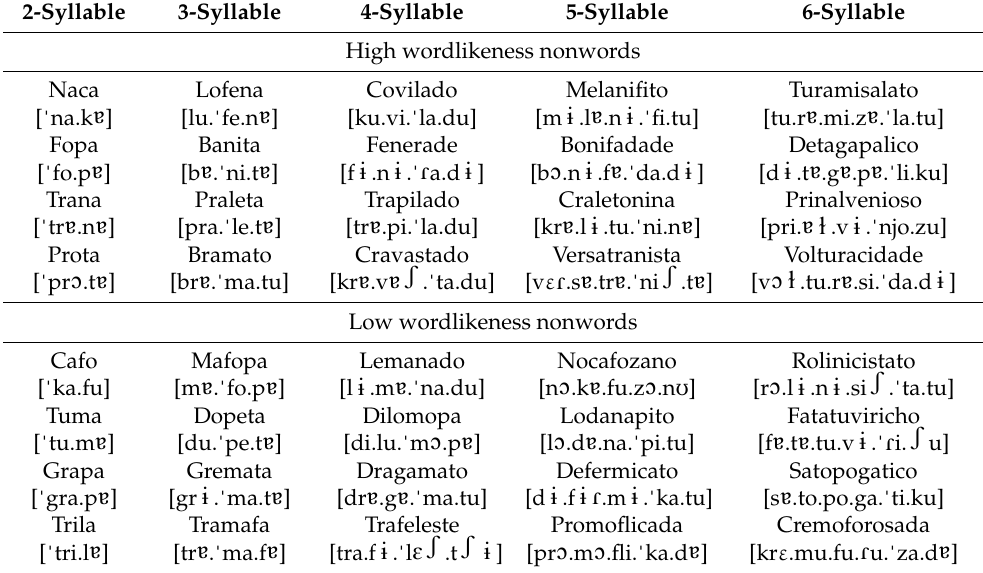
Table A2. The phonetic transcriptions in International Phonetic Transcription (IPA) of the nonwords for the European Portuguese version of the Nonword Repetition Task (NRT-EPort) by syllable length and